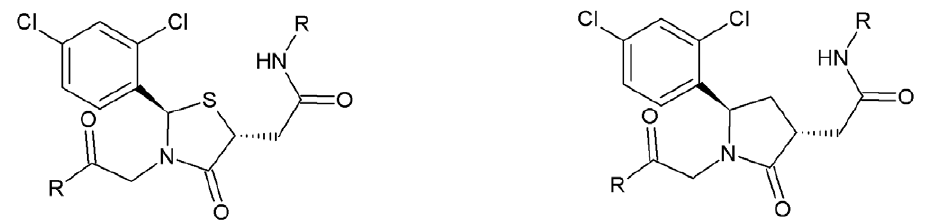
Figure 1. Structure of the thiazoline (a) and lactam (b) derivatives.